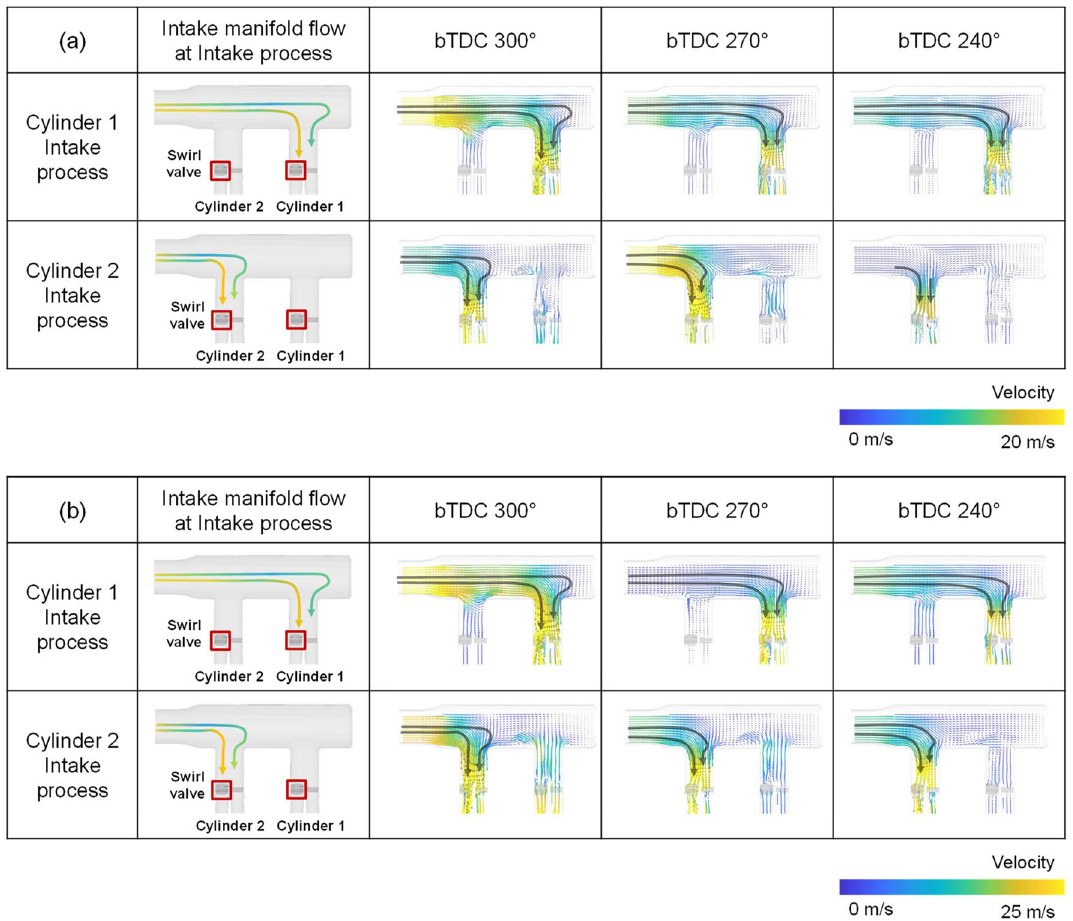
Figure 11. Cross-sectional velocity distribution for the curved manifold during intake process: ( a ) engine speed: 1500 rpm, intake pressure: 1 bar, ( b ) engine speed: 2000 rpm, intake pressure: 1